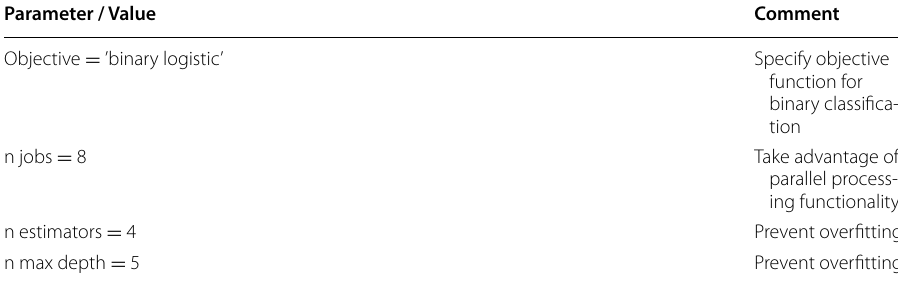
Table 2 XGBoost classifier hyper-parameters